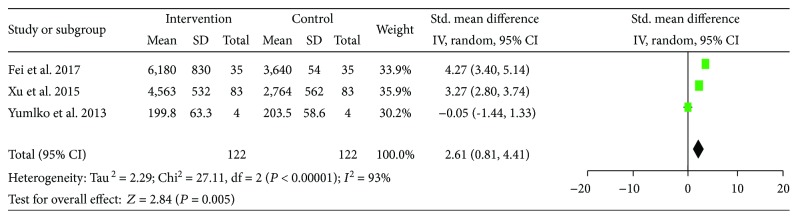
Forest plot for CHE.